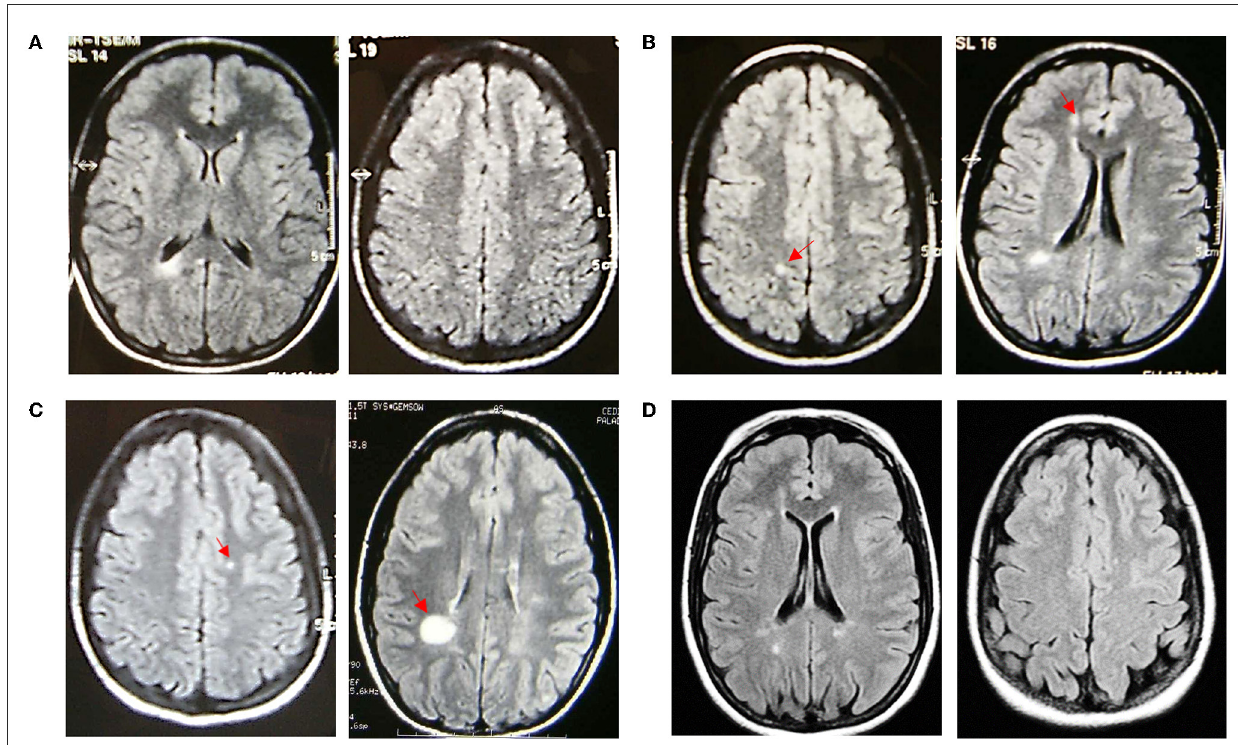
FIGURE1 Fluid attenuated inversion recovery axial sequences of MRI scans performed in the patient over time. (A) Baseline MRI on 11/07/2002; (B) MRI on the left (10/01/2003) with a new parietal right lesion (red arrow) (new cortical frontal lesion not shown), MRI on the right (12/09/2003) with a new frontal periventricular right lesion (red arrow) (left periventricular and left temporoparietal junction new lesions not shown); (C) MRI on the left (29/11/2004) showing a new left corona radiata lesion (other three new lesions not shown), MRI on the right (20/05/2005) showing a new supratrigonal right lesion (red arrow); and (D) last MRI on